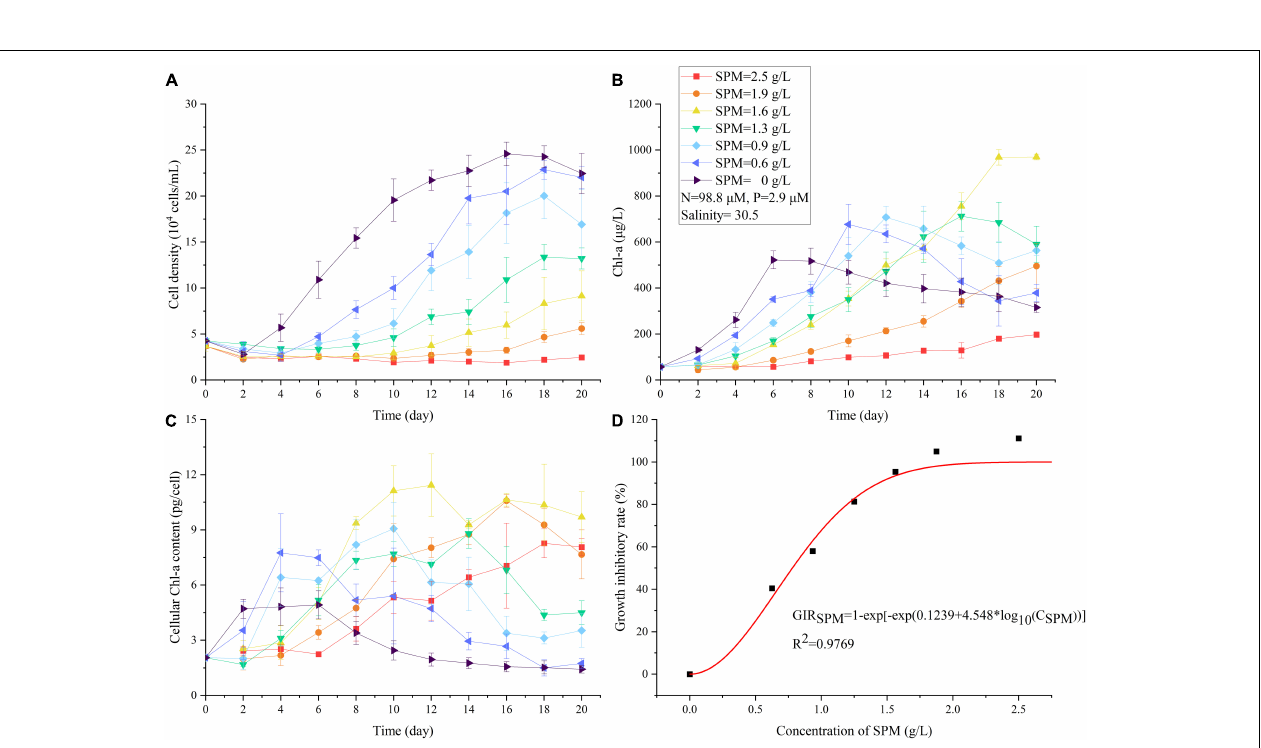
FIGURE 4 | The changes in cell density (A) , Chl- a concentration (B) , cellular Chl- a content (C) of A. carterae under different SPM concentrations in the single-factor SPM experiment. The relationship between growth inhibitory rate (GIR) and concentration of SPM (D) .